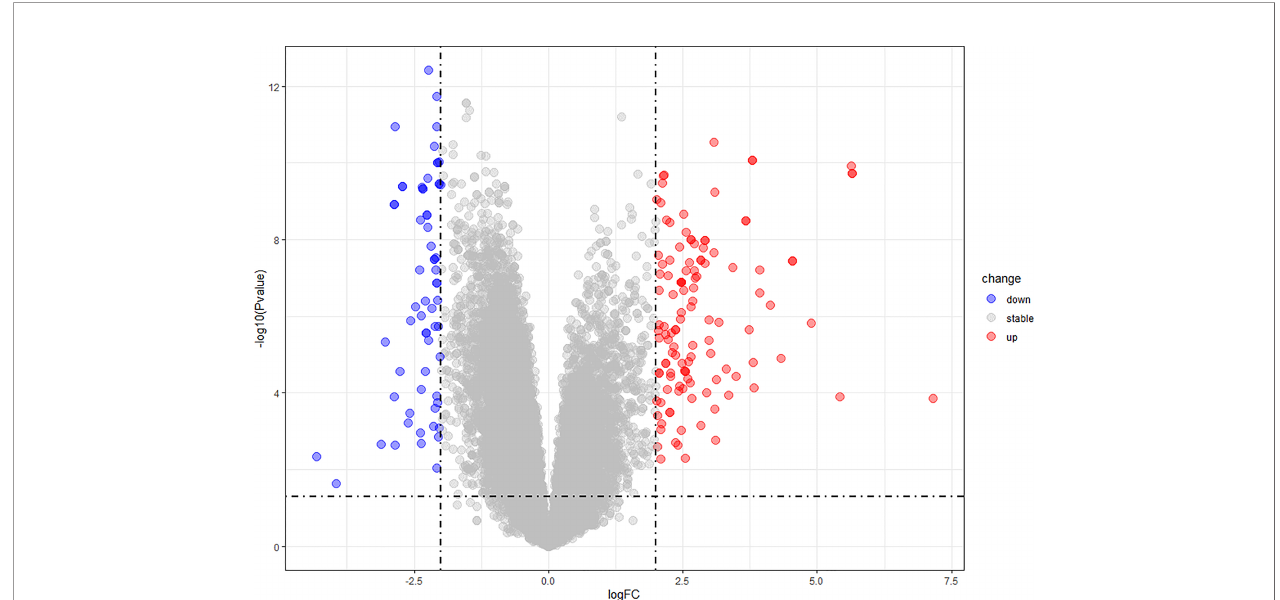
FIGURE 1 | Volcano map of